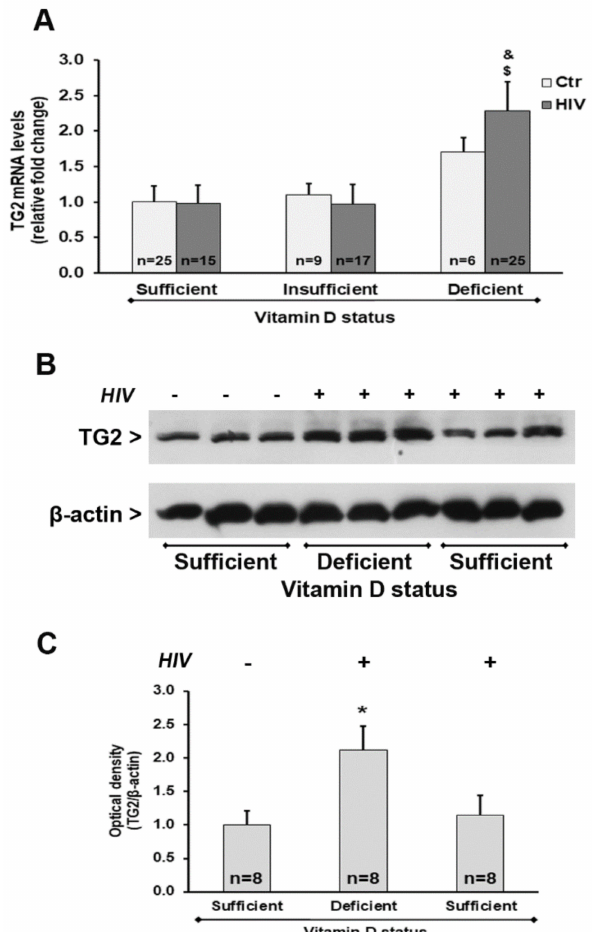
Figure 5. Tissue transglutaminase (TG2) expression in PBMC from HIV + and healthy subjects. ( A ) mRNA transcript levels were evaluated by real-time PCR. The results are expressed as mean ± SEM. ( B ) Western blot analysis of TG2. ( C ) Densitometric analysis of immunoblots. The results are representative of the values (mean ± SEM) obtained from eight subjects for each group. * p < 0.05 significant di ff erence in comparison to healthy subjects with su ffi cient 25(OH)D 3 levels; $ p < 0.05 significant di ff erence in comparison to HIV + subjects with su ffi cient 25(OH)D 3 levels; & p < 0.05 significant di ff erence in comparison to HIV + subjects with insu ffi cient 25(OH)D 3 levels. Finally, as shown by the results of the generalized linear model (GLM), all genes (except BECN1 ) were significantly influenced by at least one of the predictors included in the model. In particular, expression of TNF- α , IFN- γ , and ATG5 genes was dependent on HIV positivity and 25(OH)D 3 levels. CYP27B1 gene expression was significantly dependent on HIV infection, and a near significant dependence on 25(OH)D 3 ( p = 0.072) was also observed. LC3 gene expression was only influenced by HIV infection, and TGM2 was only influenced by 25(OH)D 3 levels (Table